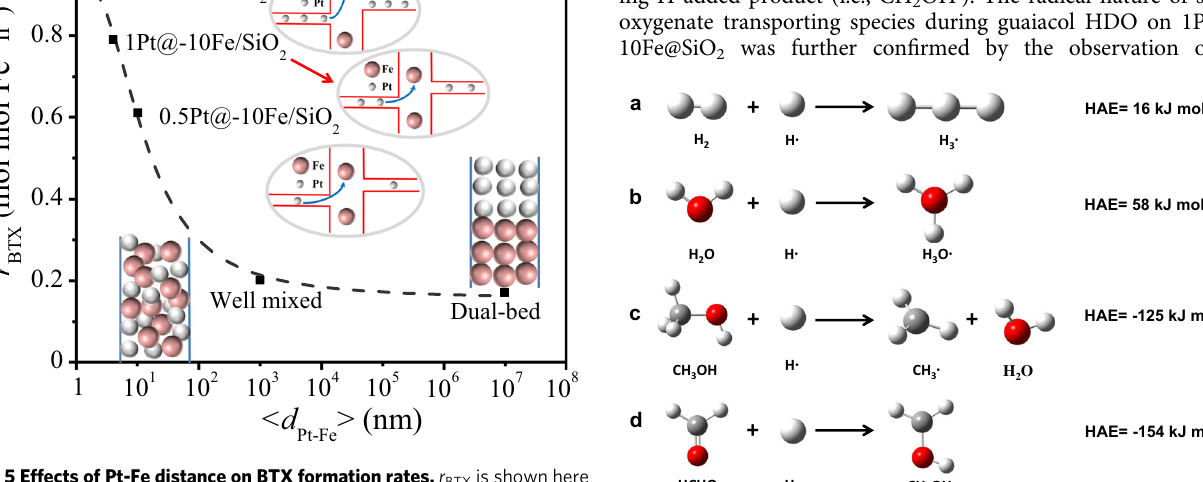
Fig. 5 Effects of Pt-Fe distance on BTX formation rates. r BTX is shown here as a function of < d Pt-Fe > for guaiacol HDO with H 2 generated in situ from methanol stream reforming (450 °C, 0.5 kPa guaiacol, 0.5 kPa methanol Fig. 6 DFT-derived H-atom addition energies (HAE). The calculations + 0.5 kPa H ∙ s ∙ mL − 1 space velocity). were carried out at the B3LYP/6-311 + G(d,p) level of 2 O, balanced by N 2 , 0. 2 5 g